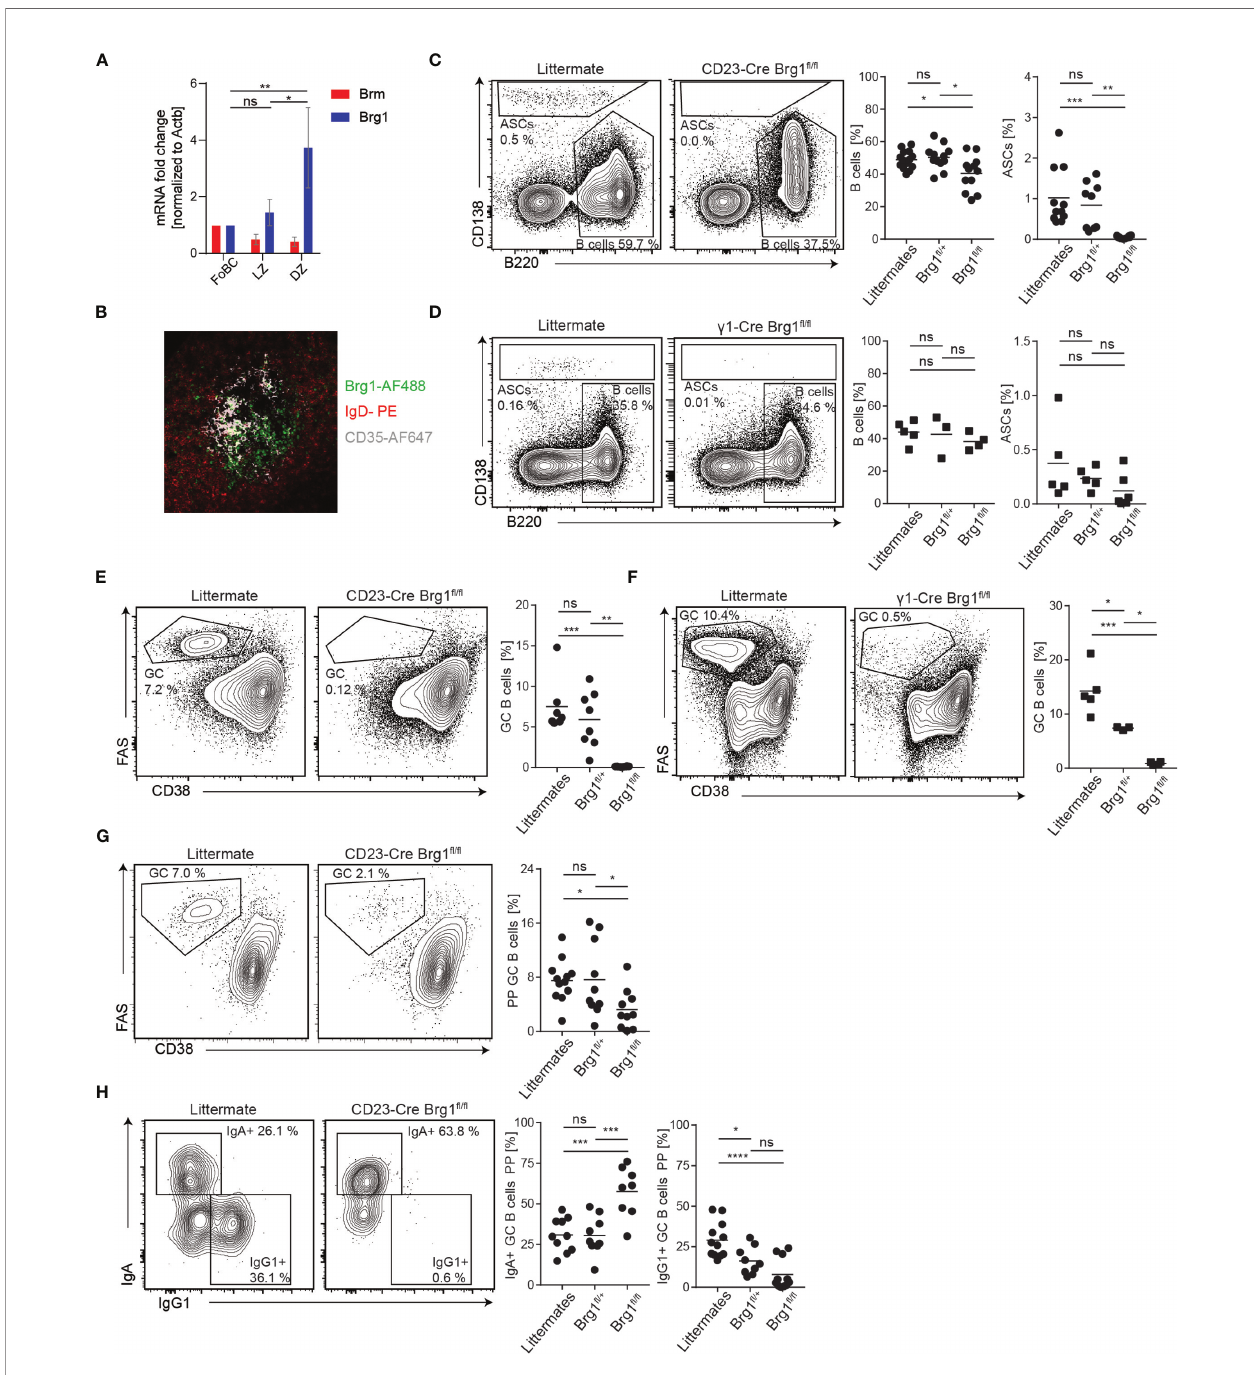
FIGURE 4 | Formation of germinal centers depends on Brg1. (A) qRT-PCR analysisof Brm and Brg1 RNA levelsrelative to Actin B levelsin follicular B cells (FoBC),light zone (LZ),and dark zone (DZ) B cells; n = 5 mice. One-way ANOVA with posthoc Tukey ’ s multiple comparisonstest was performed,followingp values for differences in Brg1 RNA levelsare represented bythe asterisks ’ : p<0.05 = *;p<0.01 = **. Changes inBrm RNA levels were not signi fi cant. (B) Staining for IgD-PE (naiveB cells), CD35- AF647 (follicular dendriticcells in the LZ) and Brg1 (clone H-88, detected with an anti-rabbit-IgG-AF488 secondary antibody)in LN-derived from immunized mouse (C) Naive B celland ASC percentages in inguinal LNdetermined by fl ow cytometry, 7dafter injection ofKLH in CFA. Each dot represents one mouse, n = 9 - 12 mice per group. One- way ANOVA with post hoc Tukey's multiple comparisonstest was used for statistical analysis. Followingp values are representedby the asterisks' inthis fi gure: p<0.05 = *; p<0.01 = **;p<0.001 = ***;p<0.0001 = ****;p>0.05 = ns (notsigni fi cant). (D) Naive B celland ASC percentages in inguinal LN determined by fl ow cytometry7dafter injection ofKLH in CFA. (E) The fraction of GC B cells in inguinal LNdetermined by fl ow cytometry, 7dafter injection ofKLH in CFA. (F) GC B cells ininguinalLNdetermined by fl ow cytometryin immunized g 1-Cre littermate, Brg1 fl /+ andBrg1 fl / fl mice, 7d after injection of KLH inCFA. (G) Flow cytometricanalysisofPP GCs inCD23-Cre littermate, Brg1 fl /+ andBrg1 fl / fl mice. (H) Quanti fi cation of IgA + and IgG1 + B cellsinPP inCD23-Cre littermate, Brg1 fl /+ and Brg1 fl / fl